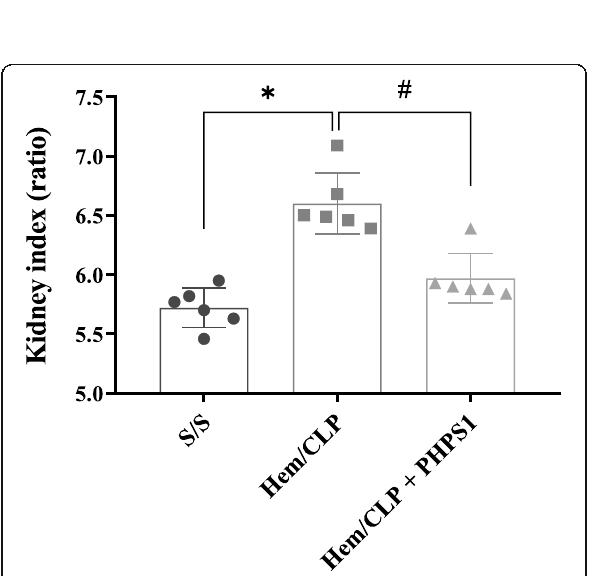
Fig. 2 PHPS1 treatment decreased kidney/body weight index (KI) elevated by Hem/CLP. The kidneys were collected 24 h post Hem/ CLP or Sham operation. Vehicle treated Hem/CLP mice showed increased KI compared to Shams and PHPS1 treated Hem/CLP mice. *, P < 0.05, versus Sham (S/S); #, P < 0.05, PHPS1 treated group (Hem/ CLP + PHPS1) versus Hem/CLP+ vehicle (Hem/CLP). One-way ANOVA and a Student-Newman-Keuls ’ test, Mean ± SD; n = 6